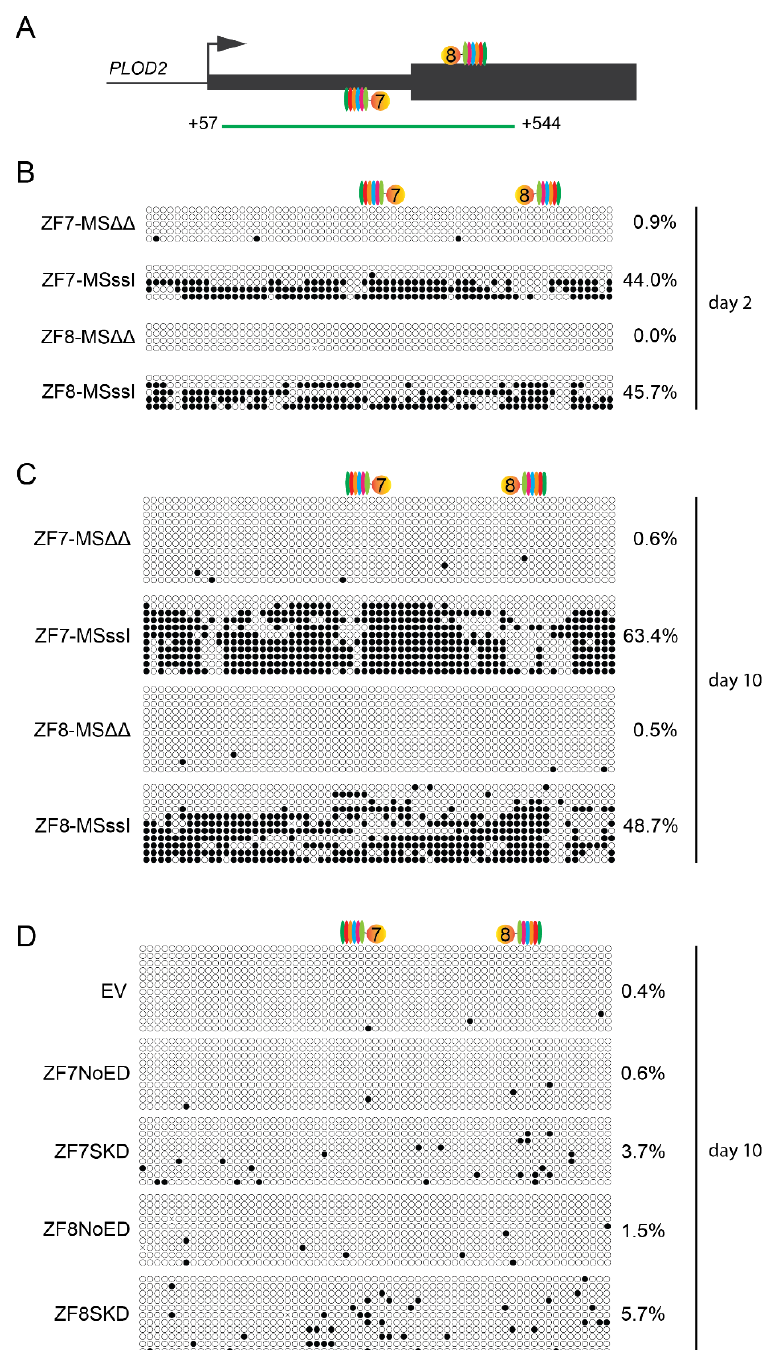
Figure 4. Analysis of DNA methylation by bisulfite sequencing in a segment of the PLOD2 gene in human dermal fibroblasts. Open circles represent unmethylated CpGs, closed circles represent methylated CpGs. The total percentage of DNA methylation is shown on the right side of the panels. (A) Schematic representation of the region probed for methylation (from +57 to +544 relative to the transcriptional start site). The numbers 7 and 8 indicate approximate positions of the target sites for the zinc fingers ZF7 and ZF8, respectively. (B) Cells stably engineered to contain the ZF-M.SssI transgene. Methylation was determined after two days of Dox treatment followed by two days of TGFβ1 stimulation. (C) The same as B, but methylation was determined after ten days of TGFβ1 stimulation. (D) Cells stably engineered to contain the ZF-SKD transgene. Methylation was determined after two days of Dox treatment followed by ten days of TGFβ1 stimulation. 2.5. SKD- and M.SssI-Induced Epigenetic Modulation in Highly Proliferative Breast Cancer Cells